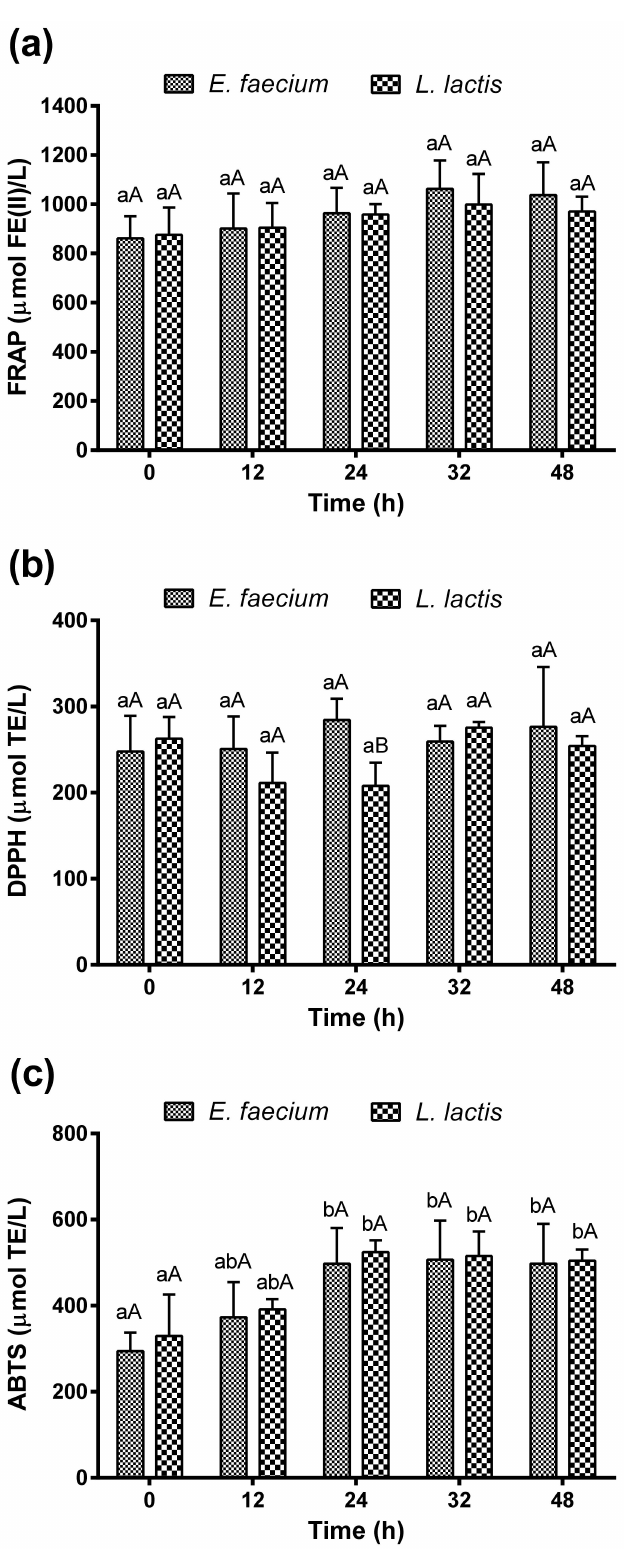
Figure 7. Antioxidant activity during fermentation with Enterococcus faecium and Lactococcus lactis by FRAP ( a ), DPPH ( b ), and ABTS ( c ). Different lowercase letters a, b show significant differences ( p < 0.05) between different fermentation times for the same bacteria. Different uppercase letters A, B show significant differences ( p < 0.05) between bacteria for the same fermentation